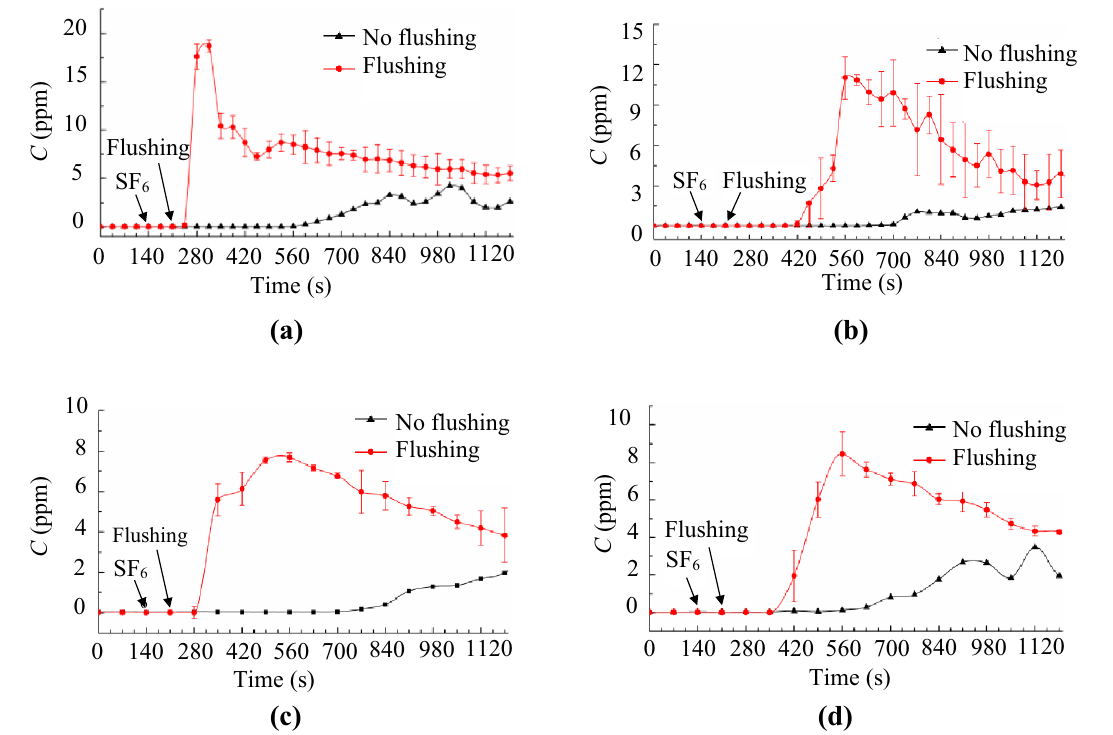
Figure 8. Transient SF 6 concentrations in breathing zone after flushing of the toilet: ( a ) at point #1 (0.4 m, 0.15 m, 1 m), ( b ) at point #2 (0.4 m, 0.15 m, 1.5 m), ( c ) at point #3 (0.7 m, 0, 1 m), ( d ) at point #4 (0.7 m, 0, 1.5 m).